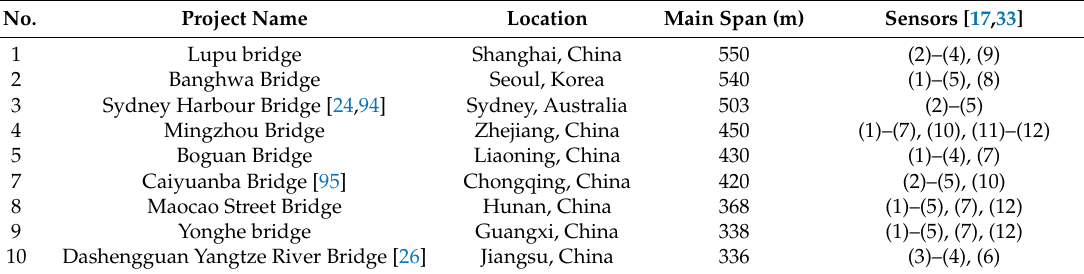
Table 3. Main arch bridges in the world equipped with SHM systems.